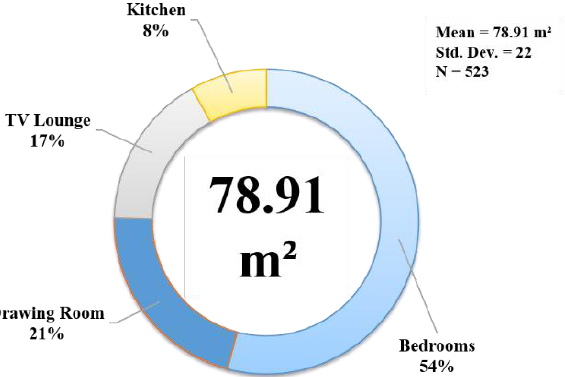
Figure 3. Percentage distribution of average floor area of a typical house in Mirpur city.